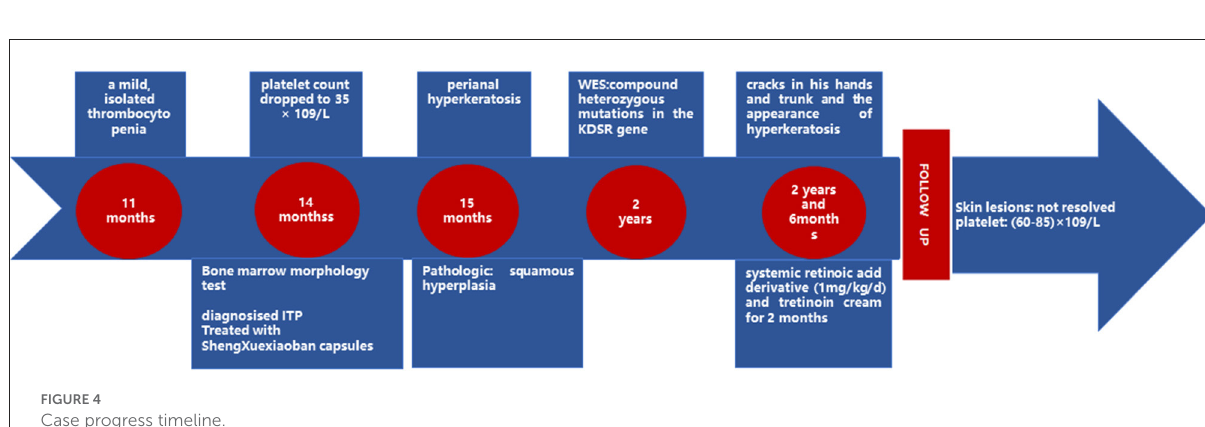
FIGURE4 Case progress